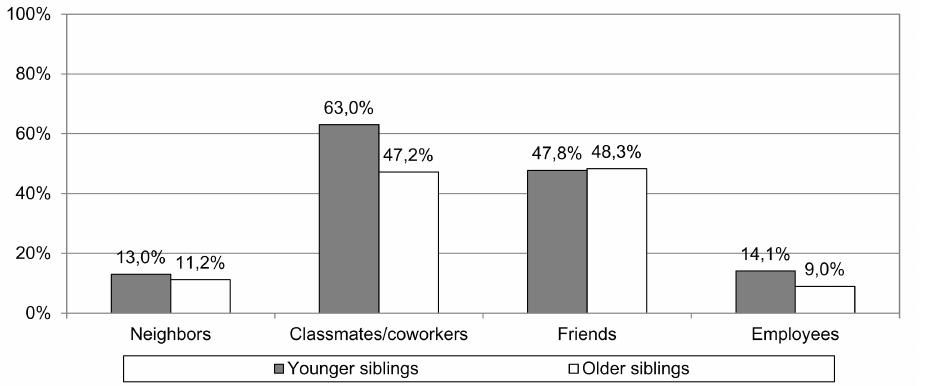
Figure 1. Percentages of “yes” responses regarding situations of contact and relation that siblings state that they have had with people of African descent.